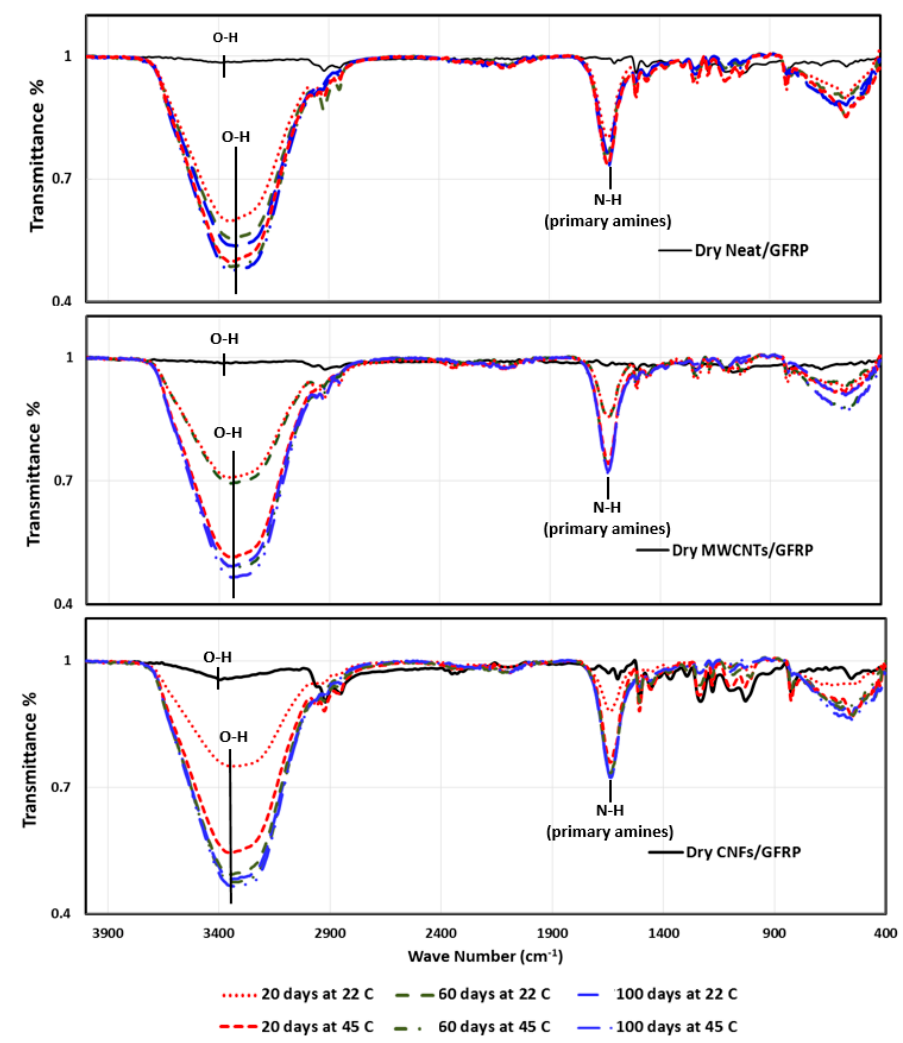
Figure 12. FTIR spectra of Neat/GFRP, MWCNTs/GFRP, and CNFs/GFRP composites.